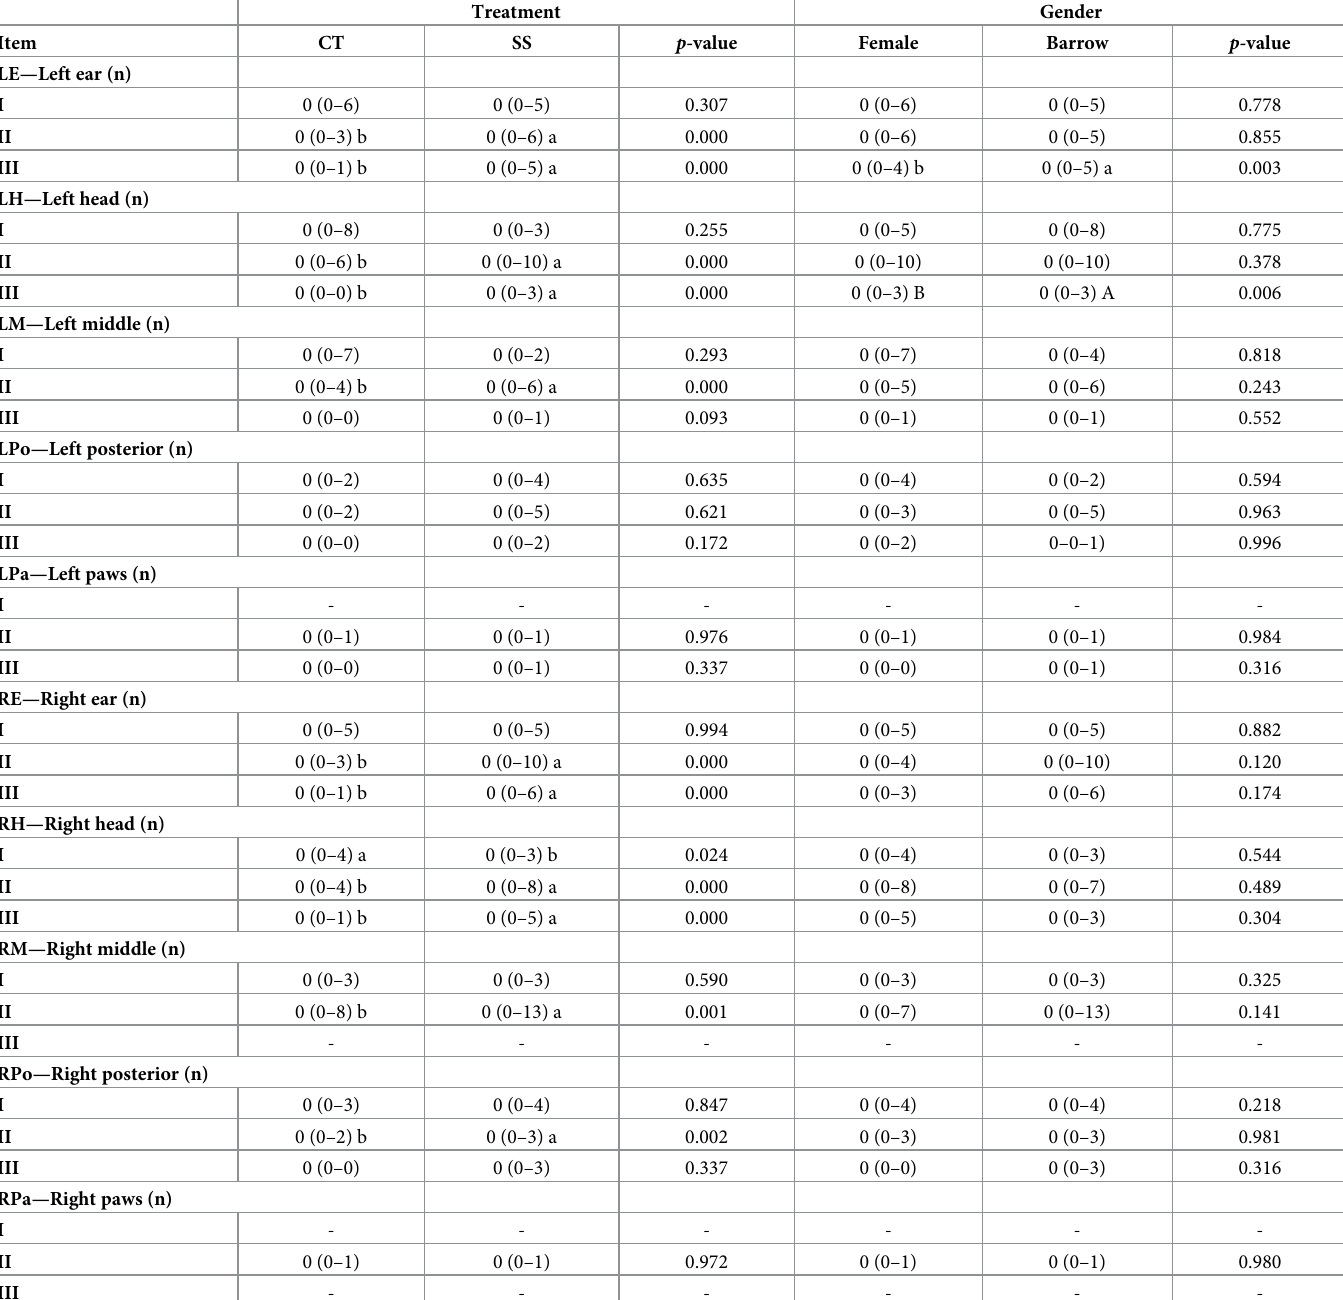
Table 7. Analysis of fresh lesion counts at different regions of growing and finishing pigs during 72 hours after mixing. Values presented as MD (median / min— max) according to treatment and